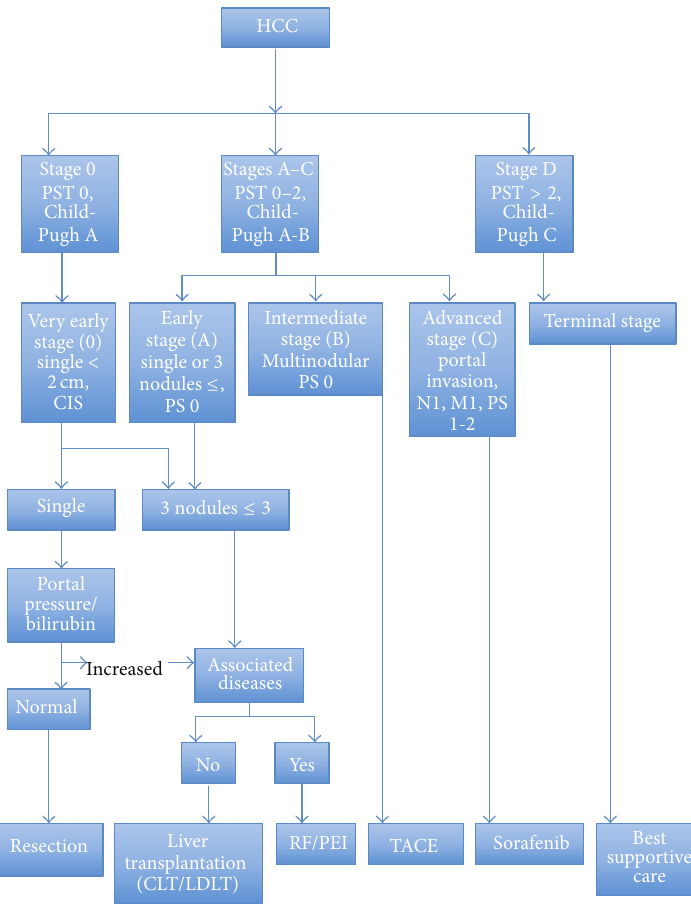
Figure 1: BCLC staging of HCC with treatment